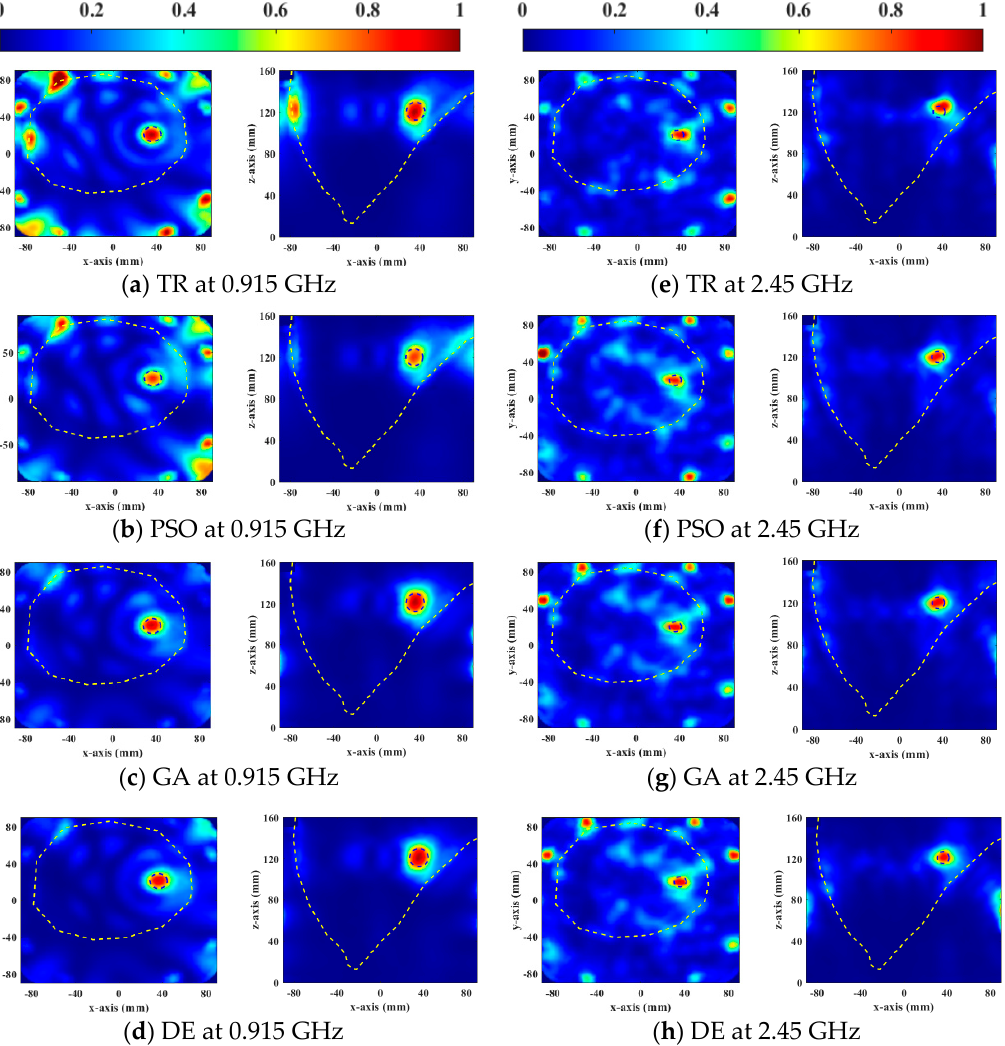
Figure 3. Normalized SAR distribution in axial (XY) and coronal (XZ) planes of a heterogeneous breast model optimized using four FMHT optimization methods.